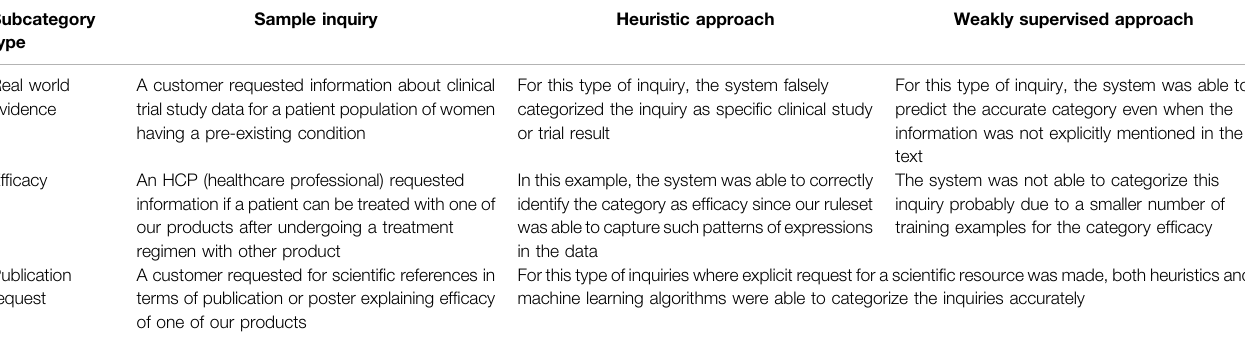
TABLE 5 | Examples of types of inquiries as well as the outcome of both heuristics and ML approaches have been presented. Due to data sensitivity, product names have been omitted and original inquiries have been slightly manipulated. Subcategory